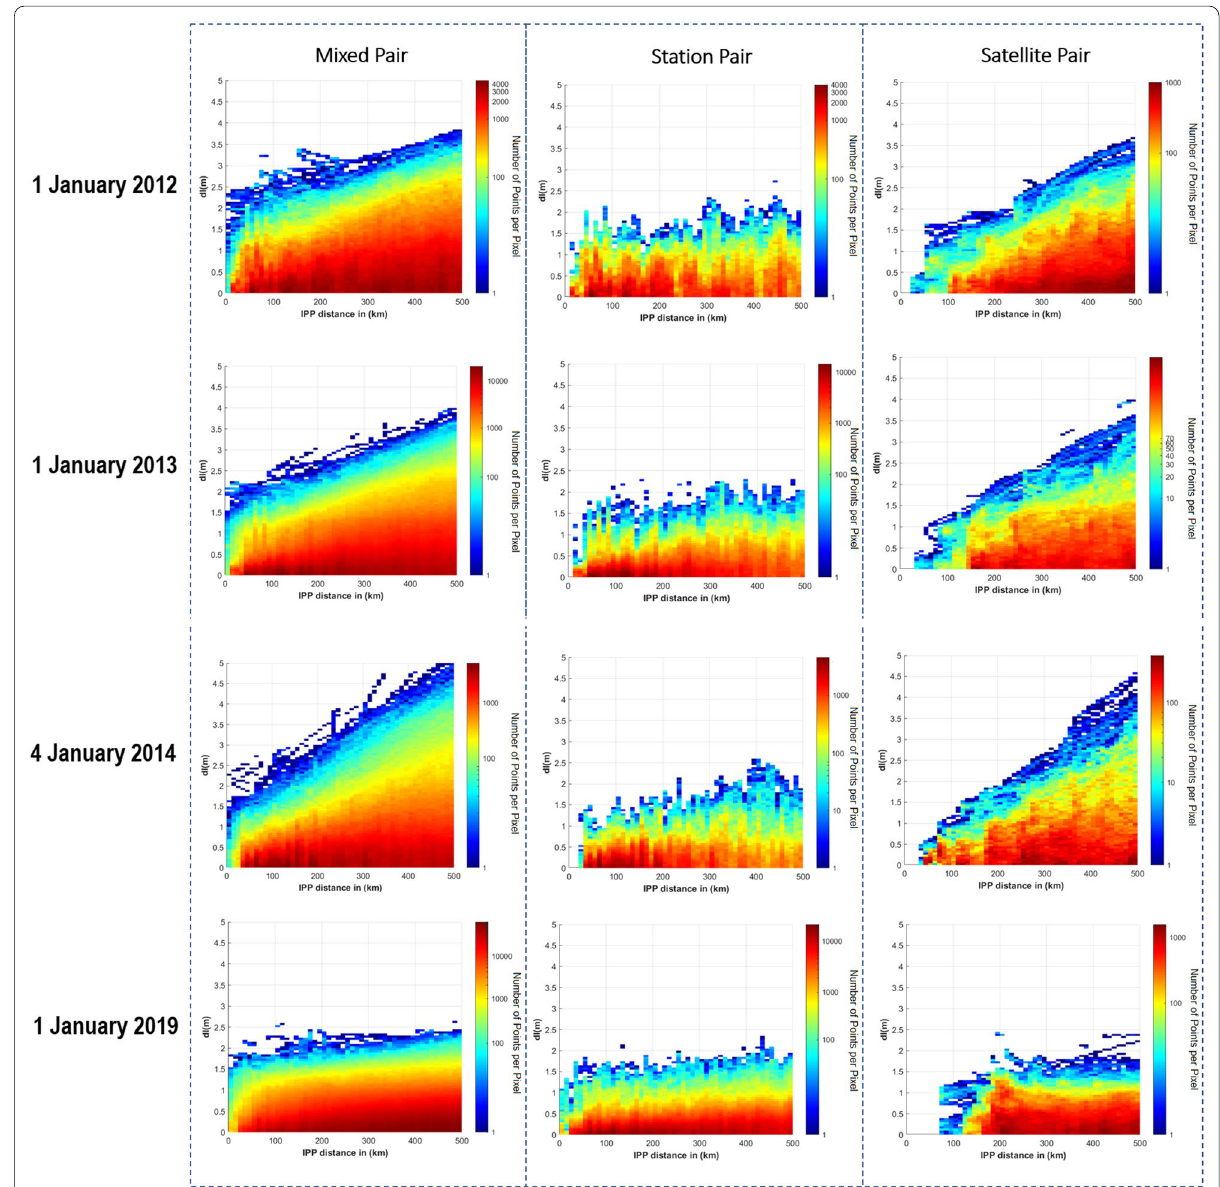
Fig. 4 Occurrences of ionospheric delay differences as a function of the IPP distance estimated by the mixed-pair, station-pair, and satellite-pair methods for 4 quiet days in different